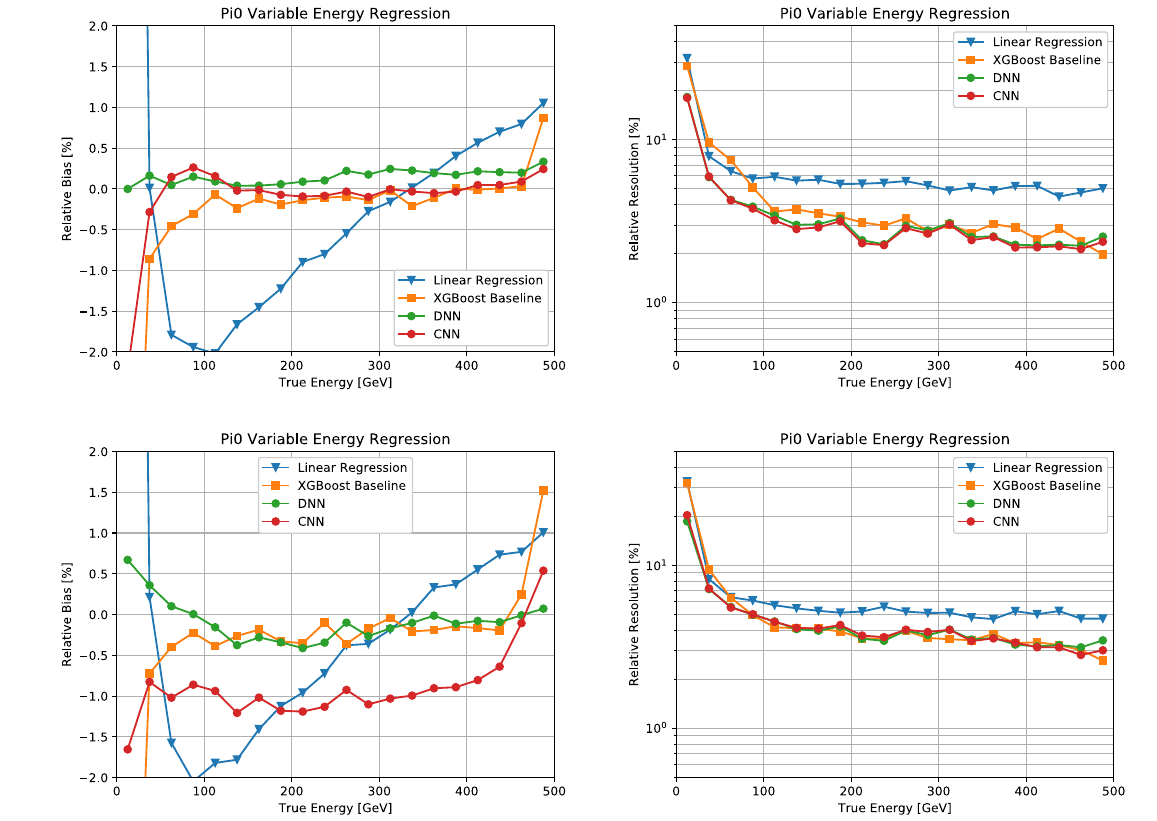
Fig. 19 Bias (left) and resolution (right) as a function of true energy for energy predictions for π 0 , on variable-angle samples resampled to ATLAS-like (top) and CMS-like (bottom)